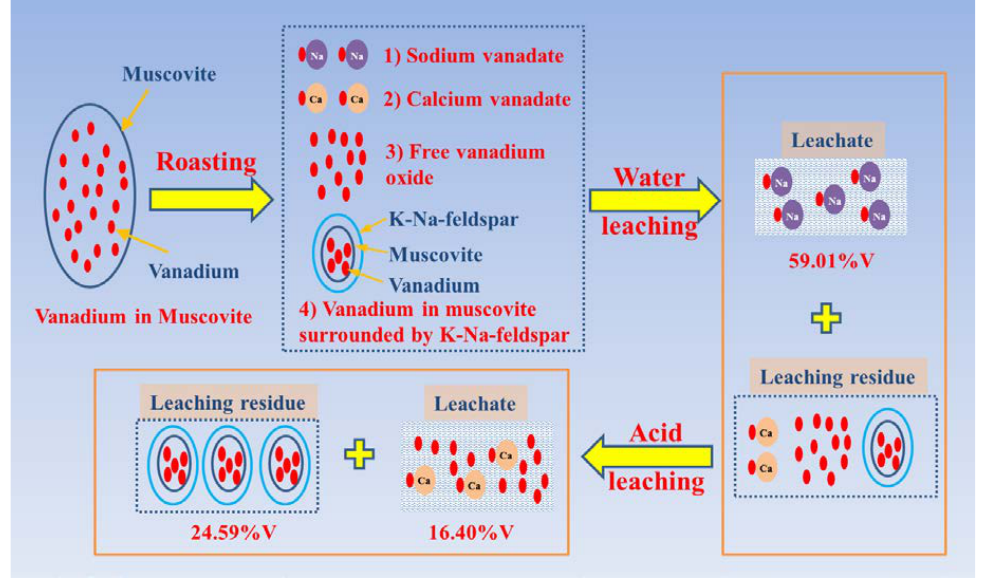
Figure 6. Schematic diagram of vanadium transitions during roasting-leaching process of vanadium extraction from stone coal.